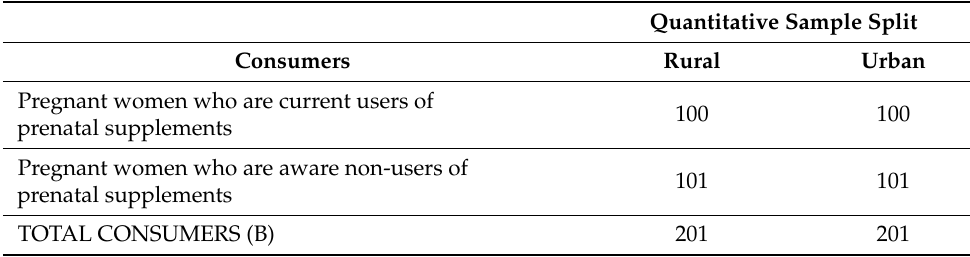
Table 1. Split between urban and rural for the consumer segments.